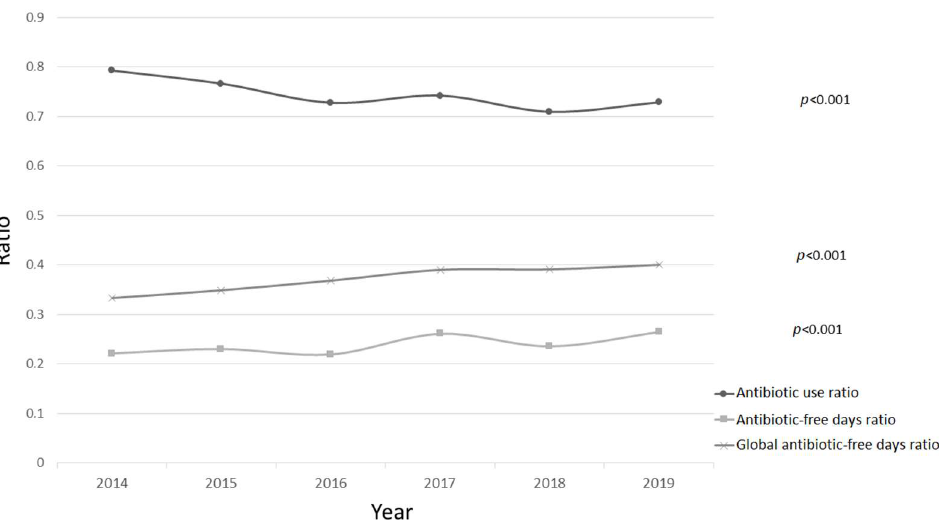
Figure 2. Representation of the evolution of different ratios regarding the use of antibiotics. Comparison of proportions between 2014–2016 vs. 2017–2019 expressed as p -values. Table 4. Use of antibiotics by suspected infection Table 4 summarizes the details by type of suspected infection, with a comparison between the two data groups. As shown, in the second period, a statistically significant increase was detected for the number of antibiotics per patient prescribed antibiotics for inside-PICU-acquired HAIs. In addition, statistically significant differences were globally